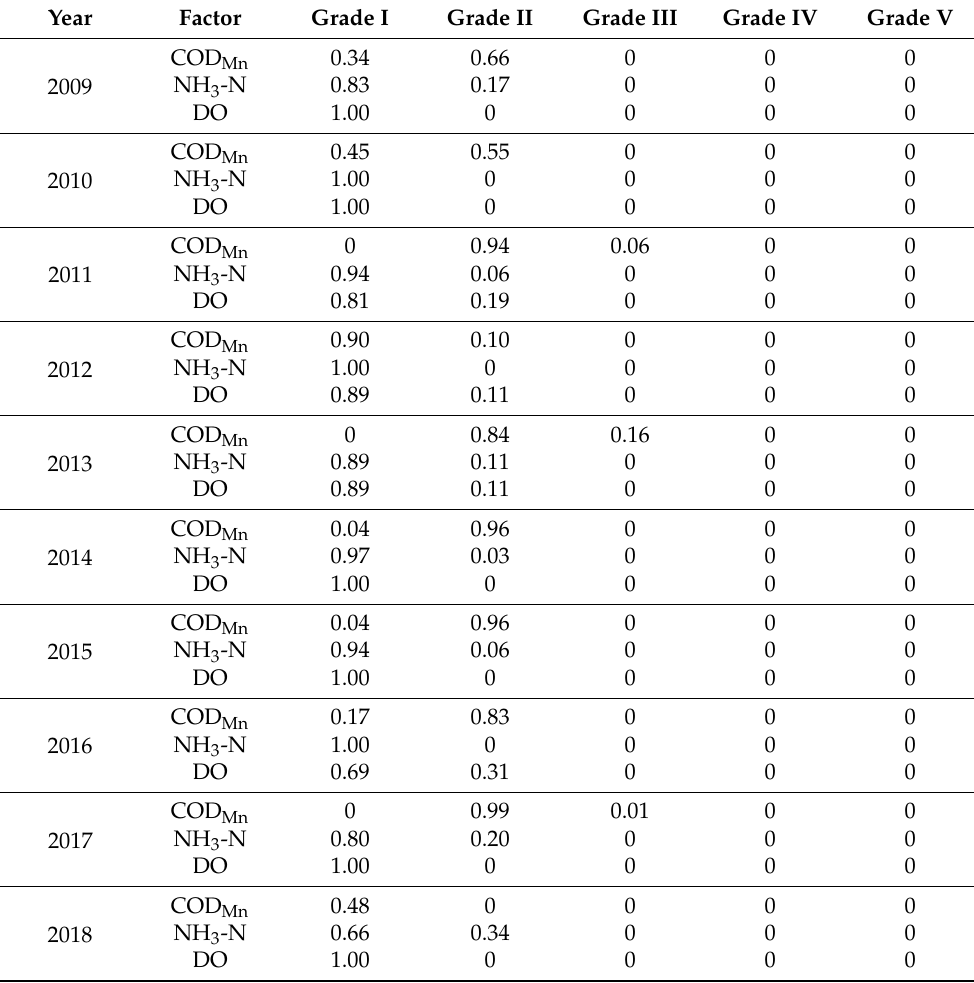
Table A6. Fuzzy matrix of Xishan Station in Suzhou,